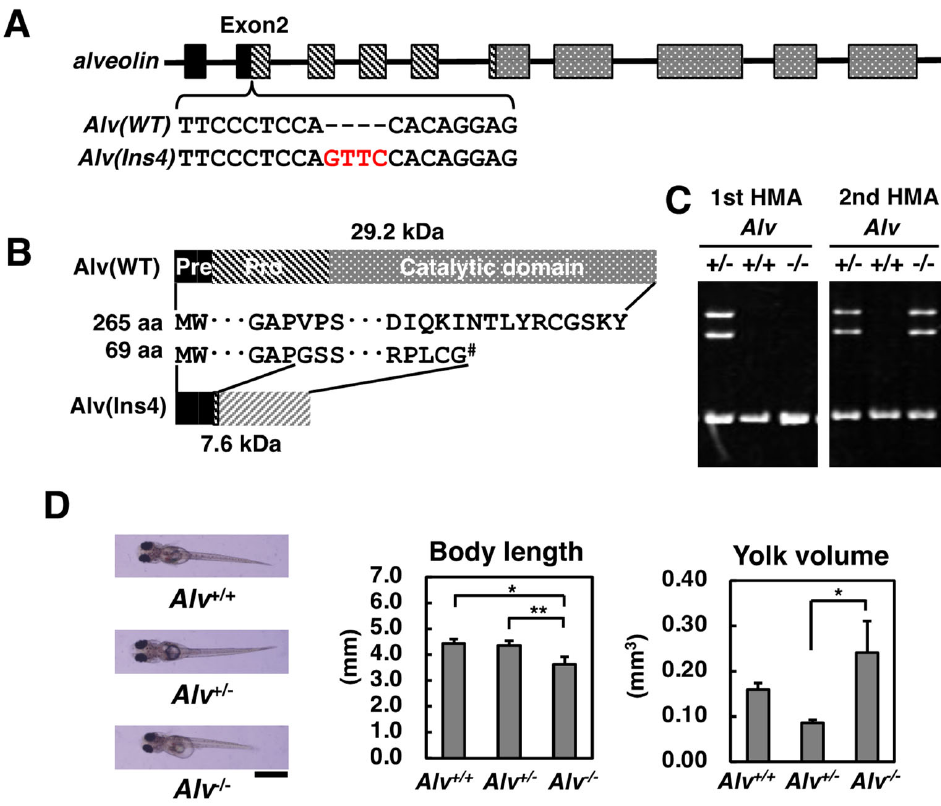
Figure 1. Generation and the pre ‐ hatching development of the Alveolin ‐ deficient medaka. ( A ) Exon/intron organization of the alveolin gene. Alv(Ins4) , a knockout allele due to a 4 bp ‐ insertion (GTTC) in exon 2 colored in red. Alv(WT) , the corresponding wild ‐ type allele. The boxes and bars stand for the exon and intron, respectively; ( B ) A 29.2 kDa ‐ polypeptide (265 aa) is synthesized from Alv(WT) allele and consists of pre ‐ , pro ‐ , and catalytic domains. A 7.6 kDa ‐ polypeptide (69 aa) is synthesized from Alv(Ins4) allele, due to the premature termination codon (#) arisen from the 4 bp ‐ insertion, and is devoid of the catalytic domain; ( C ) Genotyping through two rounds of HMAs. Alv +/+ and Alv − / − are not differentiated at the first HMA but differentiated at the second HMA after mixing with the Alv +/+ amplicon; ( D ) Phenotype of 9 dpf fry of Alv +/+ , Alv +/ − , and Alv − / − genotypes cultured in water. Photos of 9 dpf fry (left) taken from dorsal view. The scale bar, 10 mm. Body length (middle) and yolk volume (right) of fry. Volumes of yolk were calculated as described in Materials and Methods. The number of fry tested was 22, 16, and 4 for Alv +/+ , Alv +/ − , and Alv − / − , re ‐ spectively. ** p < 0.01, * p < 0.05.